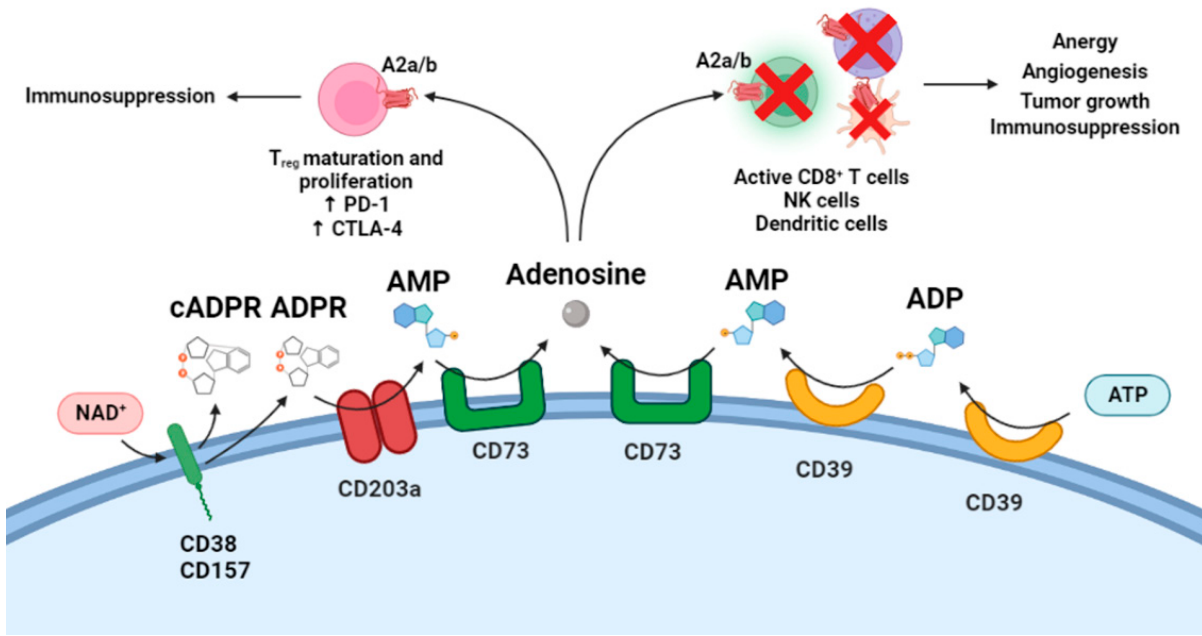
Figure 8. Schematic representation of adenosine production from NAD+ and ATP and its different effects on immune cells. A2a/b, Adenosine A2a/A2b receptors; CTLA-4, Cytotoxic T-Lymphocyte Associated Protein 4; PD-1, Programmed cell death protein 1.